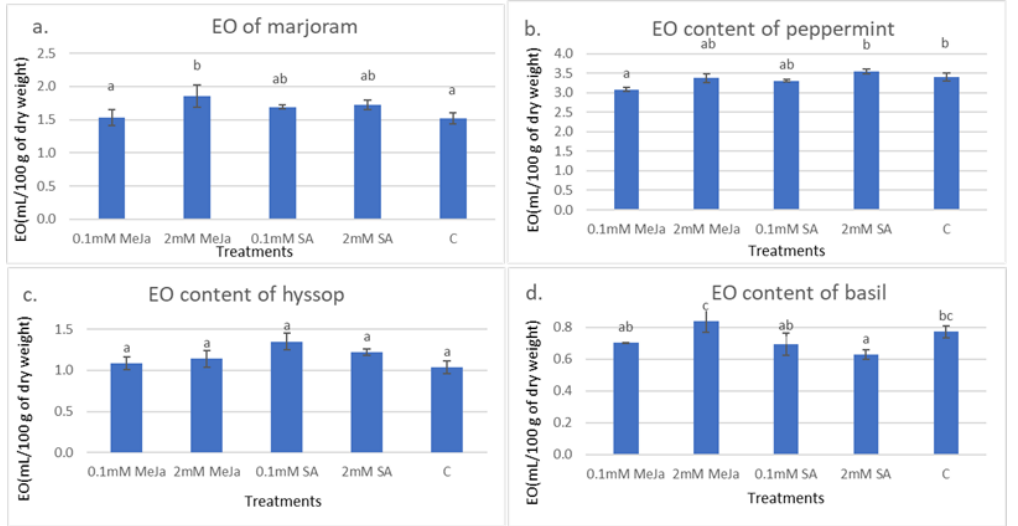
Figure 2. The effect of MeJa and SA on the EO content of the subject plants; ( a ) marjoram, ( b ) peppermint, ( c ) hyssop, and ( d ) basil; Data are expressed as means ± SD; means with different letters are significantly different ( p < 0.05).